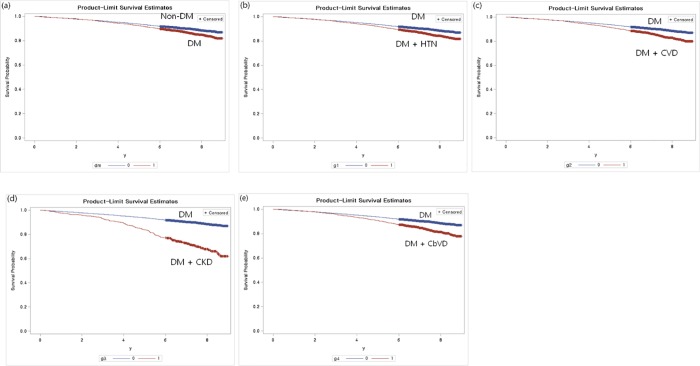
Risk of mortality from DM and comorbidities by Kaplan-Meier analysis.(a) Non-DM vs. DM. (b) DM vs. DM with HTN. (c) DM vs. DM with CVD. (d) DM vs. DM with CKD. (e) DM vs. DM with CbVD. DM, diabetes mellitus; HTN, hypertension; CVD, cardiovascular disease; CKD, chronic kidney disease; CbVD, cerebrovascular disease; vs., versus.